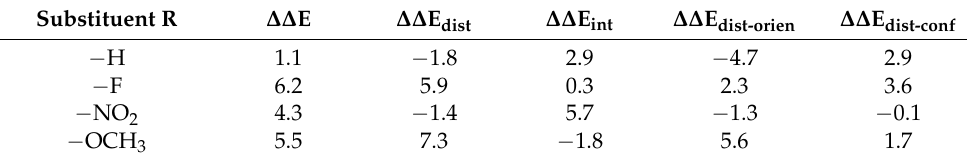
Table 3. Relative distortion and interaction energy (kcal/mol) between TS- R and TS- S . Substituent